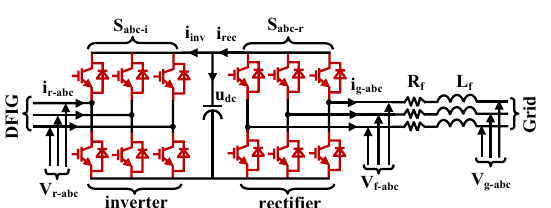
Fig. 4 Topology of the back-to-back converter [81] K sh is the factor of shaft stiffness in (pu/rad), and D sh is rad., and ω b is the base angular velocity.